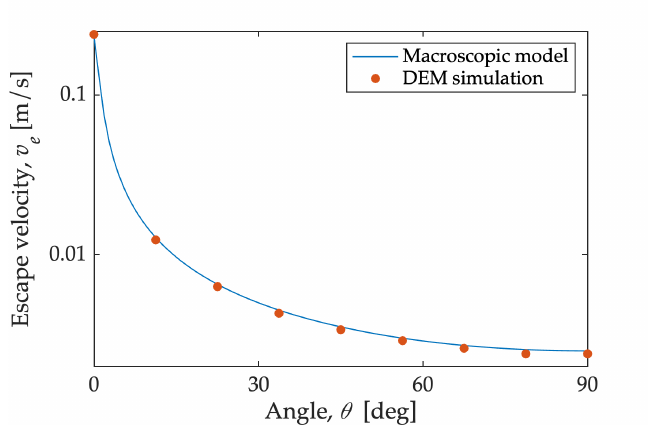
Figure 8. Comparison between analytical model for the escape velocity (Equation (A54)) and DEM simulations with MFIX (SJKR cohesion model).